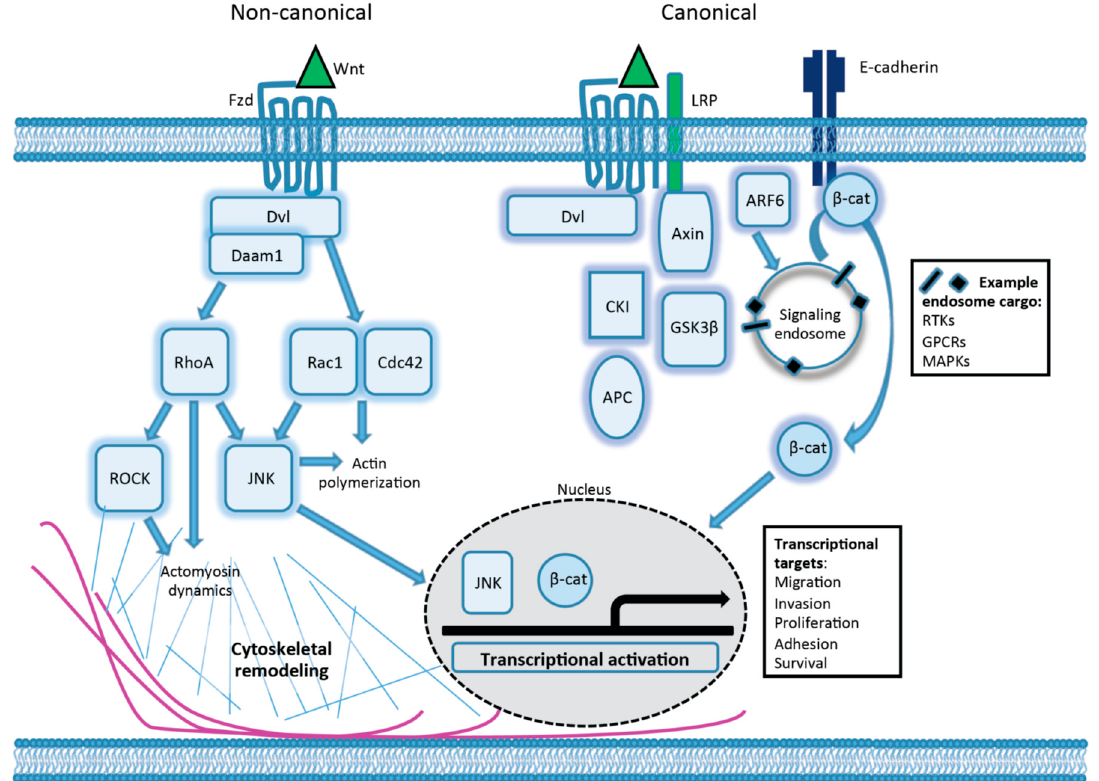
Figure 1. Canonical and non-canonical Wnt pathways influence cell migration and invasion.